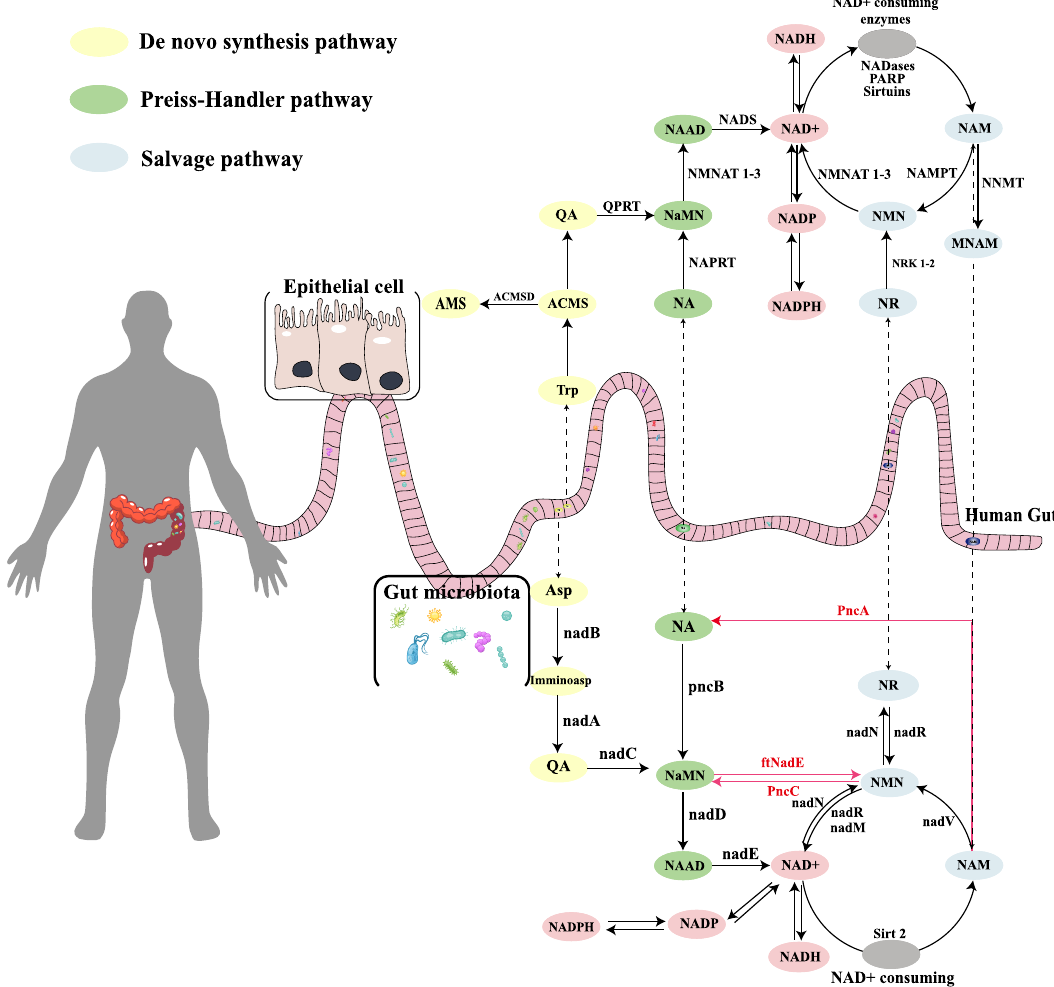
Fig. 1 The synthesis and consumption pathways of NAD + in mammals and intestinal fl ora. Two main pathways involved in mammalian NAD synthesis: de novo and salvage pathway. The former pathway converts Trp to QA through the kynurenine pathway and synthesizes NAD + . The main precursors of NAD + are NAM, NA, NR, and NMN. NAD + -consuming enzymes mainly include SIRTs, PARPs, and CD38, and the metabolites after they use up NAD all contain NAM. In the intestinal fl ora, the de novo synthesis of NAD + mainly depends on Asp rather than Trp. Although different in the de novo pathway, they share the same precursors for NAD + synthesis. Dependence on the same precursors must lead to competition or cooperation in NAD + metabolism between mammals and their microbiota. The synthetic pathway marked by the red line is speci fi c to gut fl ora. Trp tryptophan, ACMS α -amino- β - carboxymuconate- ε -semialdehyde, QA quinolinic acid, AMS α -amino- β -muconate- ε -semialdehyde, NaAD nicotinic acid adenine dinucleotide, MNAM methylation of NAM, Asp aspartic acid, ImminoAsp immino-aspartate, QPRT nicotinate-nucleotide pyrophosphorylase, NMNAT Nicotinamide/nicotinic acid mononucleotide adenylyltransferase, NADS glutamine-dependent NAD + synthetase, NNMT nicotinamide N-methyltransferase, NRK nicotinamide riboside kinase, NADP nicotinamide adenine dinucleotide phosphate. Figure 1 was created by Adobe